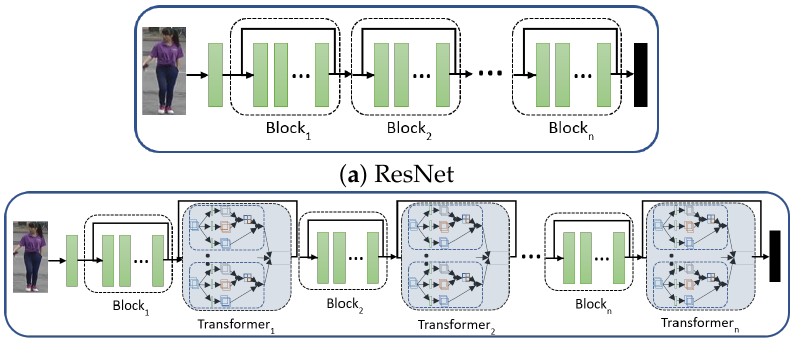
Figure 4. The architecture of ( a ) ResNet (baseline) and ( b ) Residual Transformers. The fundamental difference between the baseline and Residual Transformers (RTr) is that the transformers after each block is integrated. The number of transformer modules (M), heads (h), and integration after the levels (L) depends on the variant of the Residual